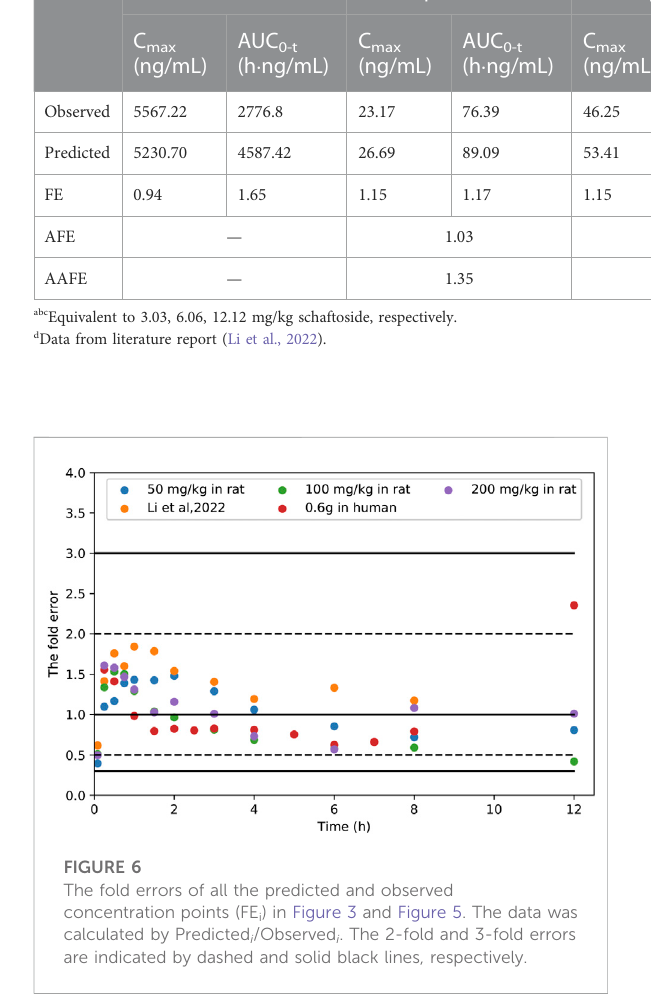
TABLE 5 Predicted and observed pharmacokinetic parameters of schaftoside in rats. The accuracy of the prediction is expressed as fold error (the ratio of predicted to observed).